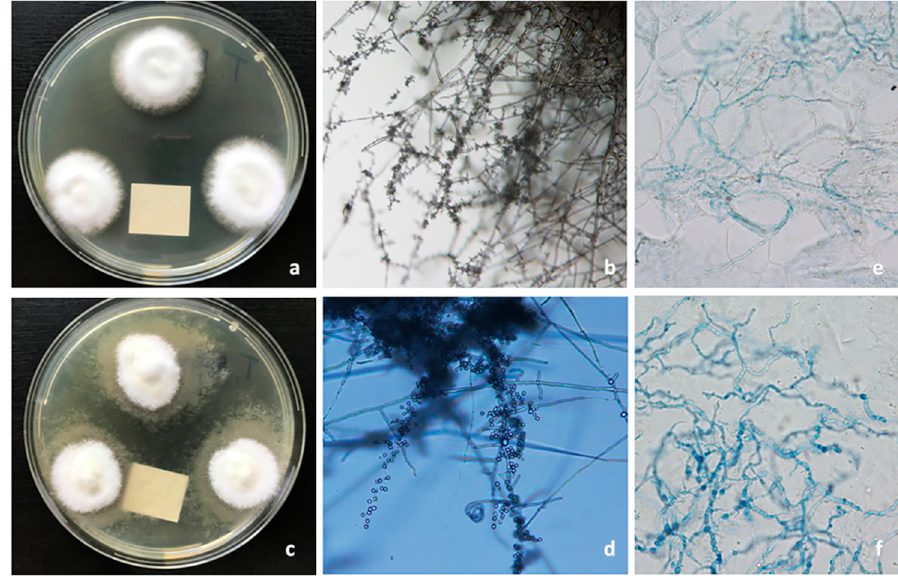
Figure 3. Mycological examination: ( a ) T. rubrum colonies, 10-day-old culture on malt extract agar incubated at 26 ◦ C. ( b ) T. rubrum macro- and micro-conidia in microculture on Sabouraud agar (200 × magnification). ( c ) T. interdigitale colonies, 10-day-old culture on malt extract agar incubated at 26 ◦ C. ( d ) T. interdigitale mycelium and microconidia in microculture on Sabouraud agar (200 × magnification). ( e ) Microscopic image of T. rubrum dermatophytic hyphae in the nail samples (KOH + Myko-Ink stain, 400 × magnification). ( f ) Microscopic image of T. interdigitale dermatophytic hyphae in the nail samples (KOH + Myko-Ink stain, 400 ×